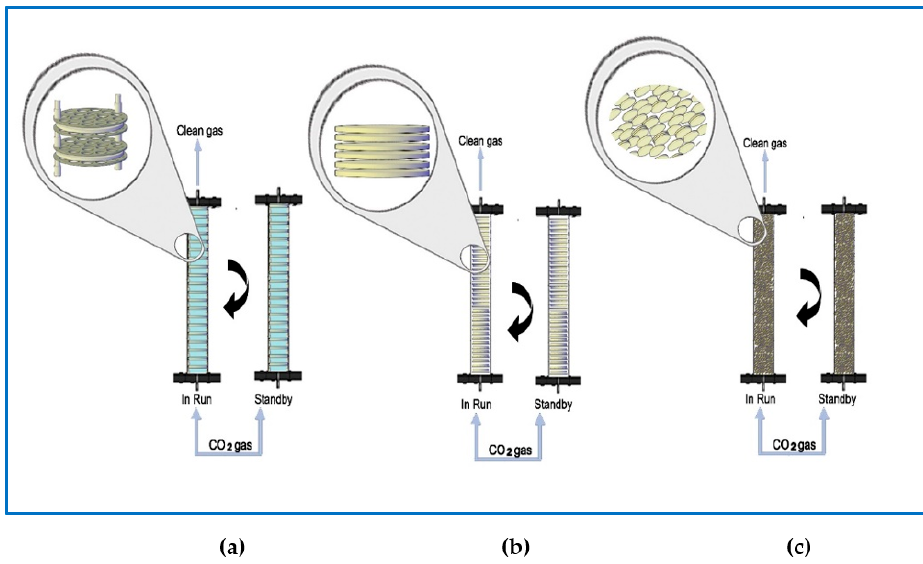
Figure 5. Model designed for CO 2 capturing using buffered ( a ) multi-spaced puffed rice cakes (MSPRC), ( b ) stacked puffed rice cakes (SPRC), and ( c ) puffed rice grains (PRG).